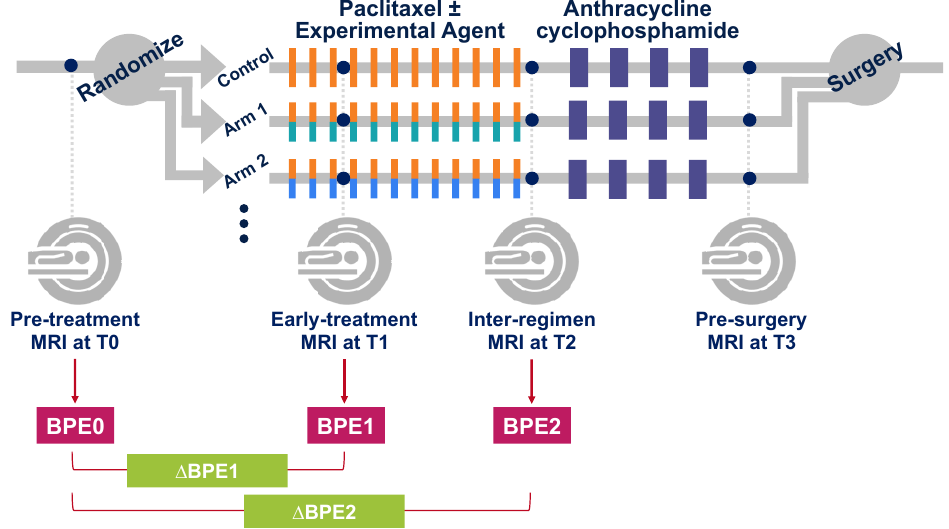
Figure 1. I-SPY 2 study schema with adaptive randomization.